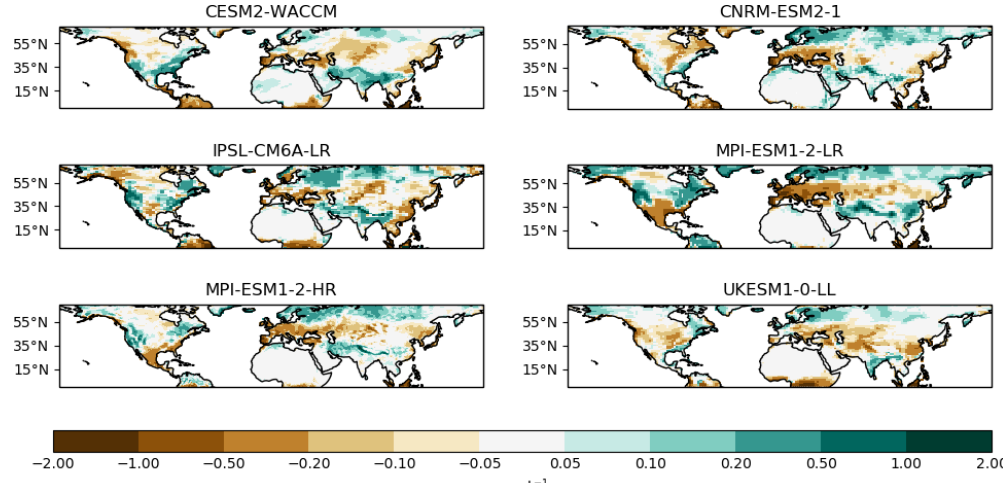
Figure 4. As Fig. 3 but for land precipitation rate (mmd − 1 ).